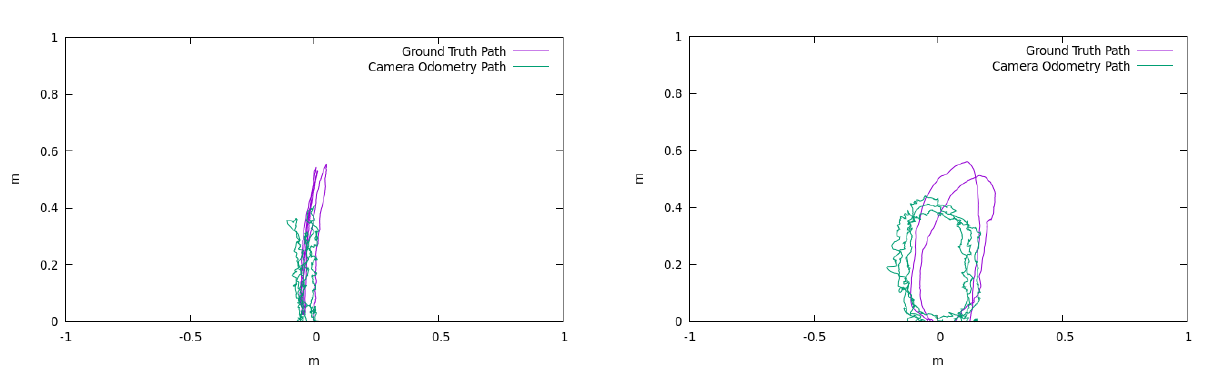
Figure 7. Tracking path for circular movement with calibrated camera.